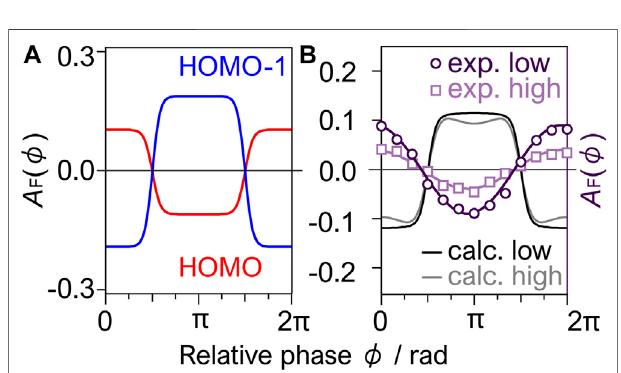
FIGURE 9 | (A) Phase dependence of the asymmetry parameter A ( ϕ ) calculated for HOMO and HOMO-1 with the acceptance angle of θ 0 = 45 ° . (B) Total asymmetry parameter compared with the experimental parameter for F fragment, A F ( ϕ ), calculated at I ω +2 ω = 1.4 × 10 14 W/cm 2 (solid) and 3.0 × 10 14 W/cm 2 (gray), in comparison with the corresponding experimental results (circle and square, respectively).